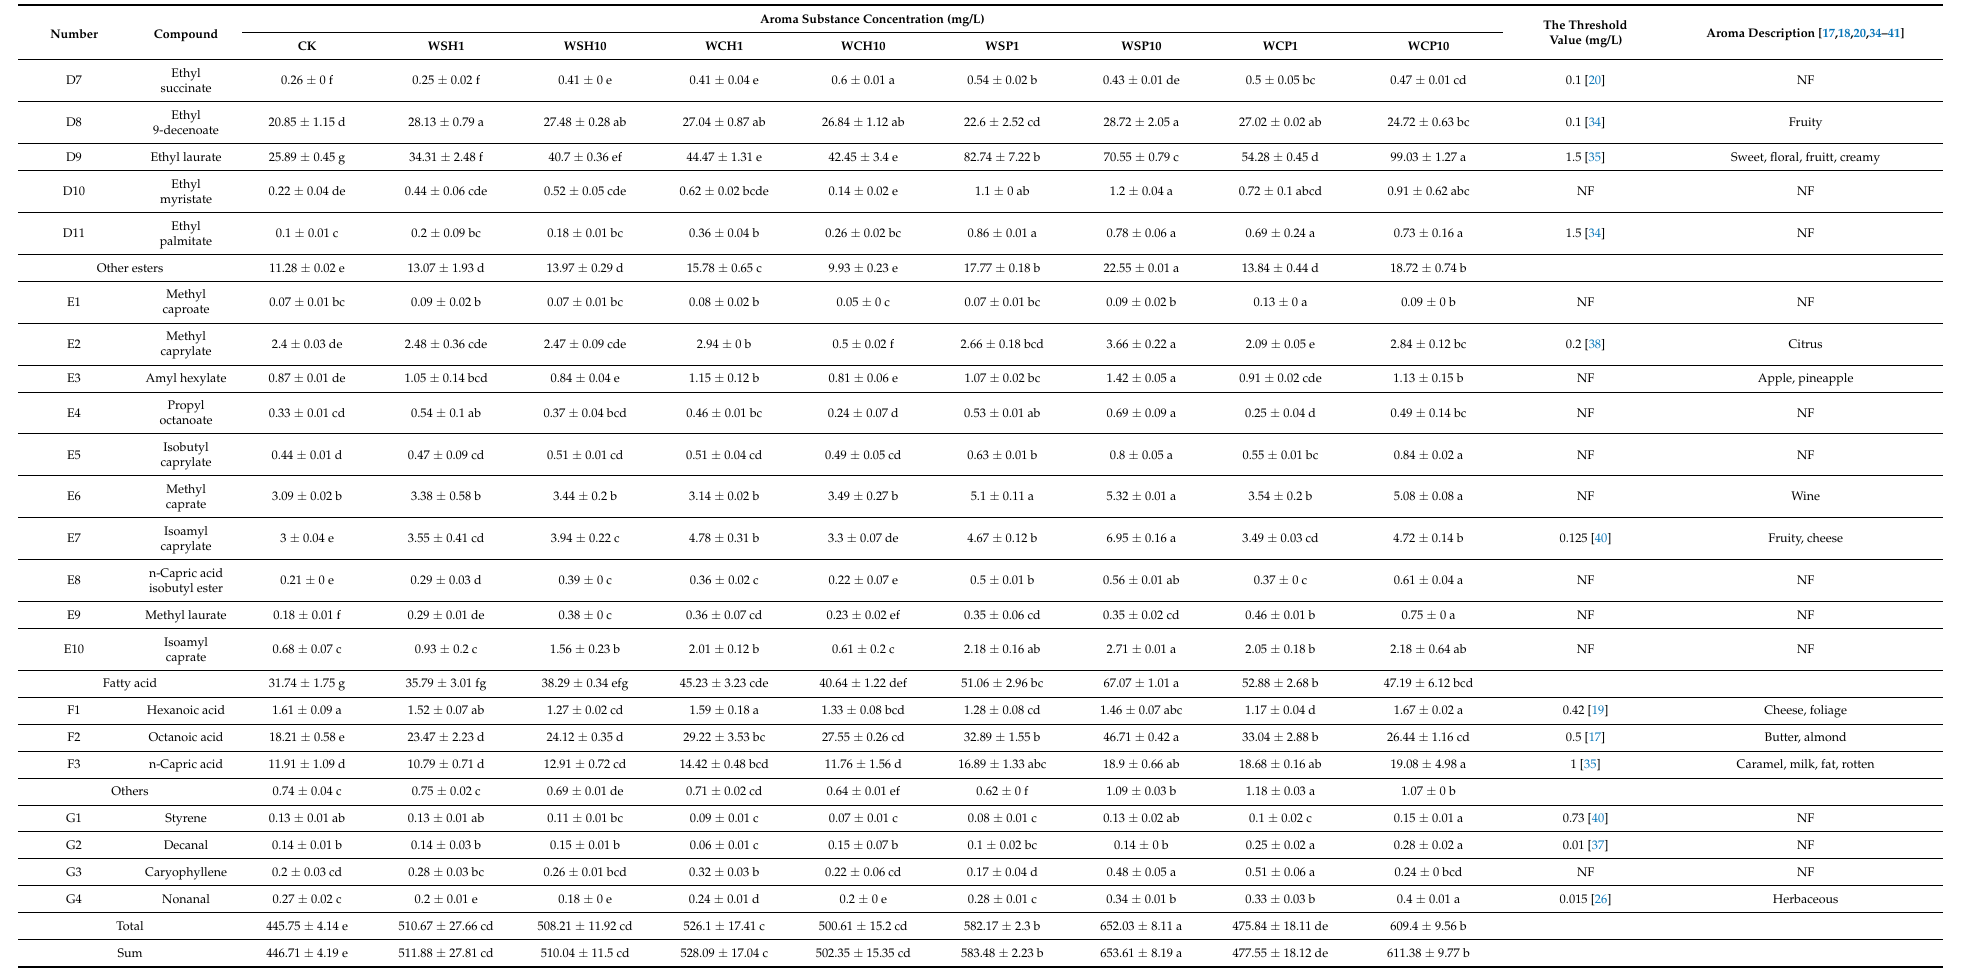
Note: The data are presented in the form of ‘mean ± standard deviation’. In the rows, different lowercases represent significant differences between treatments (Duncan’s test, p < 0.05). ‘NF’ is not